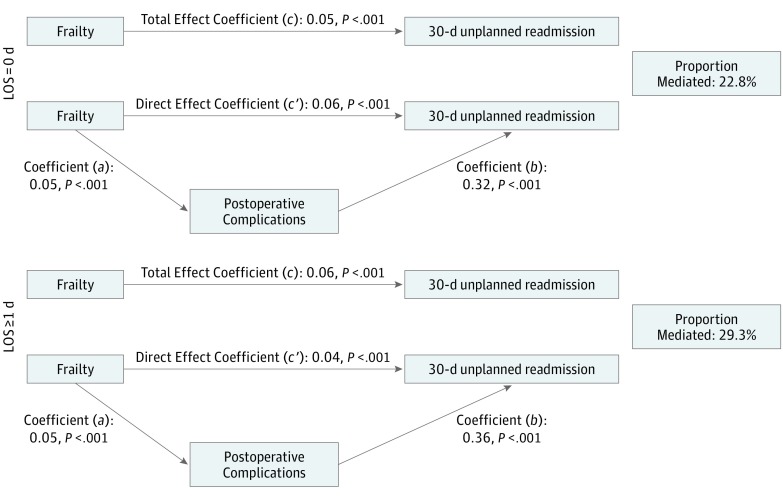
Mediation AnalysisLOS indicates length of stay.